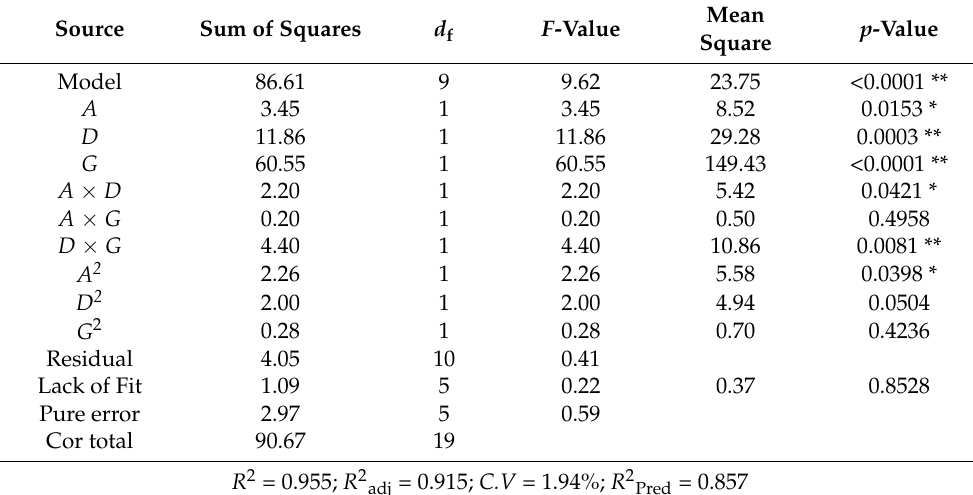
Table 8. The regression variance analysis of the significant influencing factors (the Poisson’s ratio of FJF A , the static friction coefficient of FJF–FJF D , and the static friction coefficient of FJF–steel plate G ) by the analysis